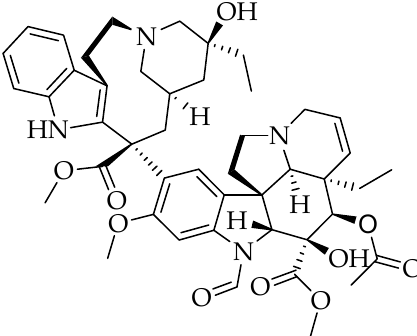
Figure 12. The chemical structure of vincristine.